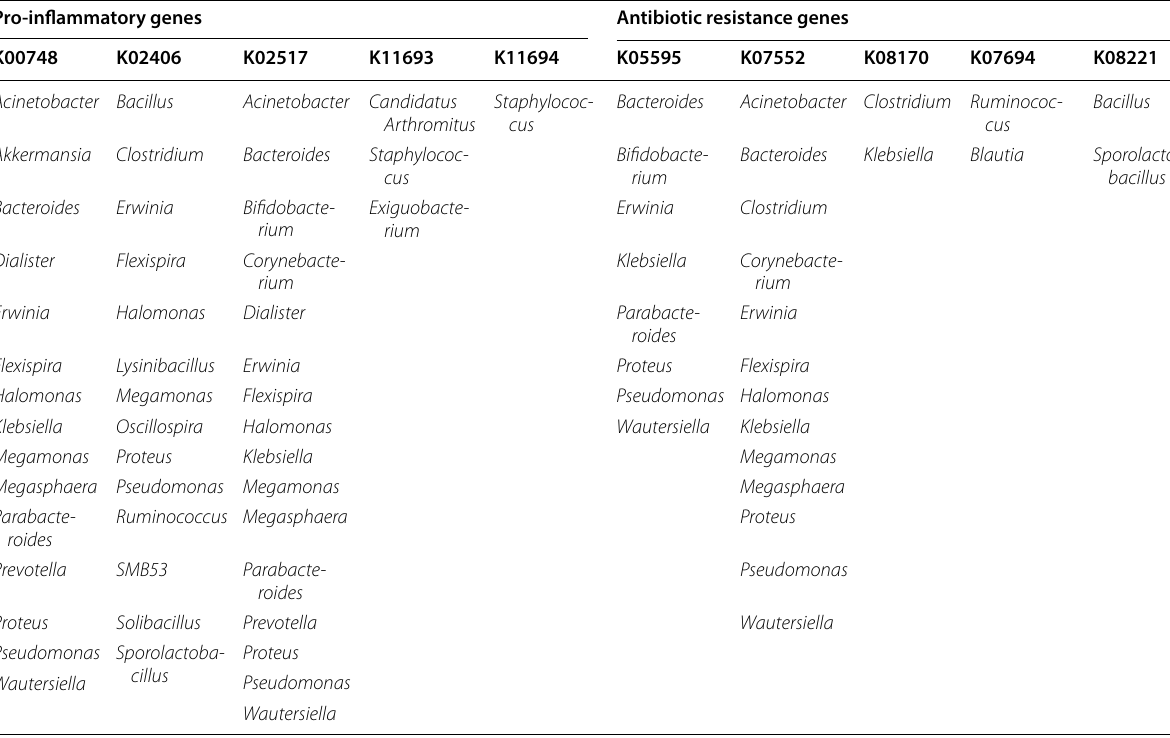
Table 3 PICRUSt predicted genes and corresponding bacterial genus involved in antibiotic resistance and pro- inflammatory activities in